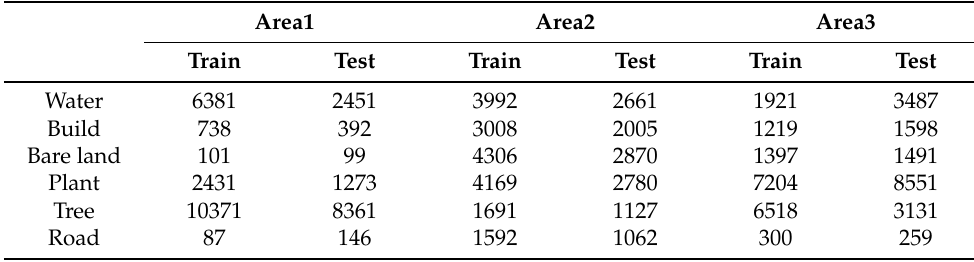
Table 3. Details of the ground truth in